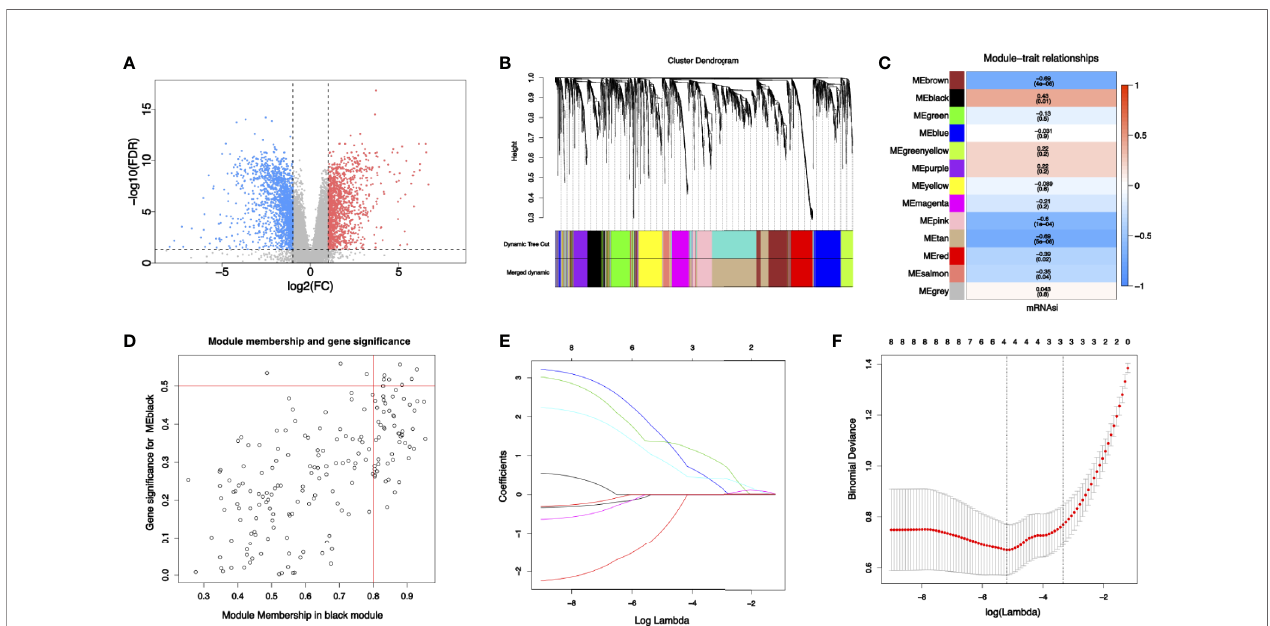
FIGURE 2 | (A) Differential gene expression analysis: blue represents downregulated genes and red represents upregulated genes. (B) Identi fi cation of modules by gene co-expression network in HNSCC. The branches of the cluster dendrogram indicate the modules and the leaves on the cluster dendrogram indicate genes. (C) Modules correlated with mRNAsi. The number is the correlated coef fi cient. The number in parenthesis is the P value. (D) Scatterplots of module eigengenes. (E, F) The least absolute shrinkage and selection operator analysis (LASSO). Coef fi cient pro fi les of four stemness-related genes identi fi ed to construct risk score